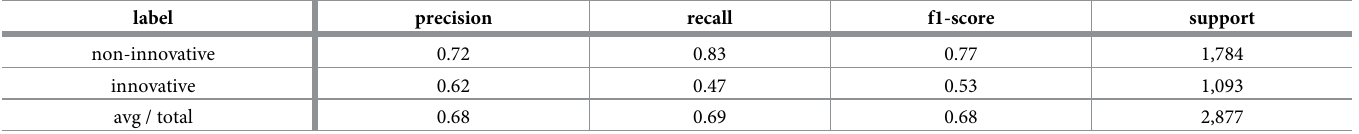
Table 5. Product innovator classification report for alternative data test set A.